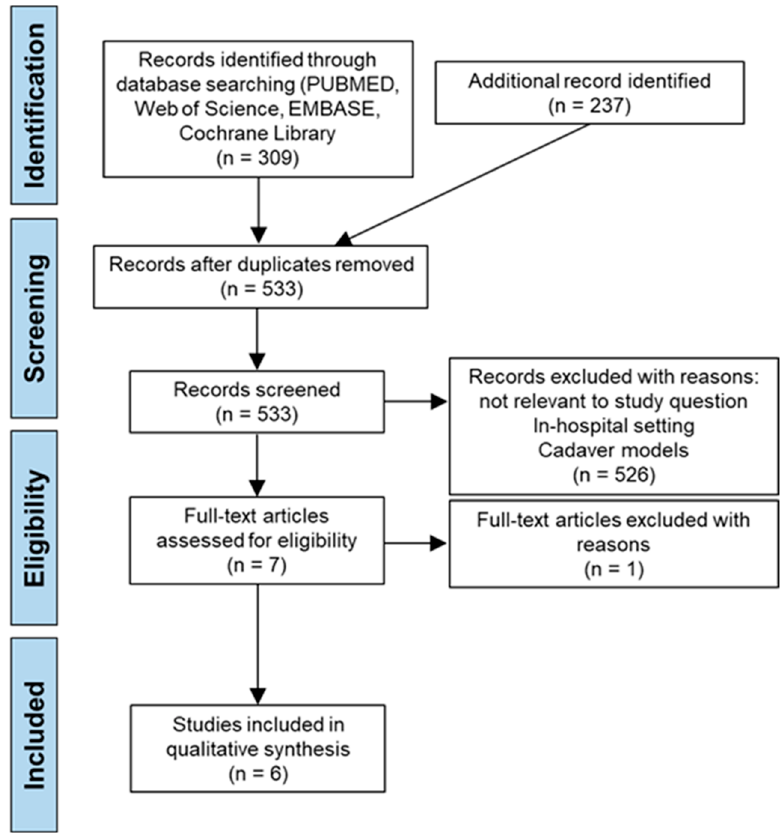
Figure 1. PRISMA flow diagram.